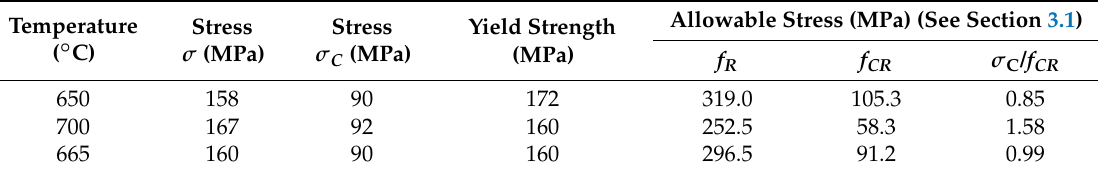
Table 2. Maximum longitudinal stress.